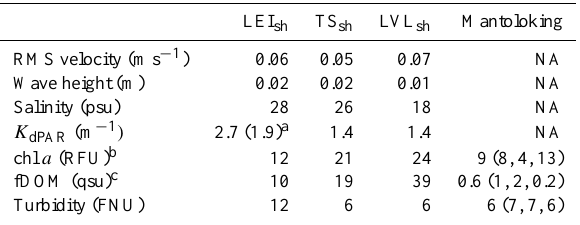
Table 2. Sediment grain-size results for combined samples col- Table 1. RMS values of velocity (absolute value), and median val- lected near deployment sites with mini-SEABOSS grab ues of wave height, salinity, light attenuation K dPAR ) , and attenu- ating constituents from three sites and reference site Mantoloking. Value in parentheses at Mantoloking covers the same temporal over- lap of the study sites. LEI sh TS sh LVL sh